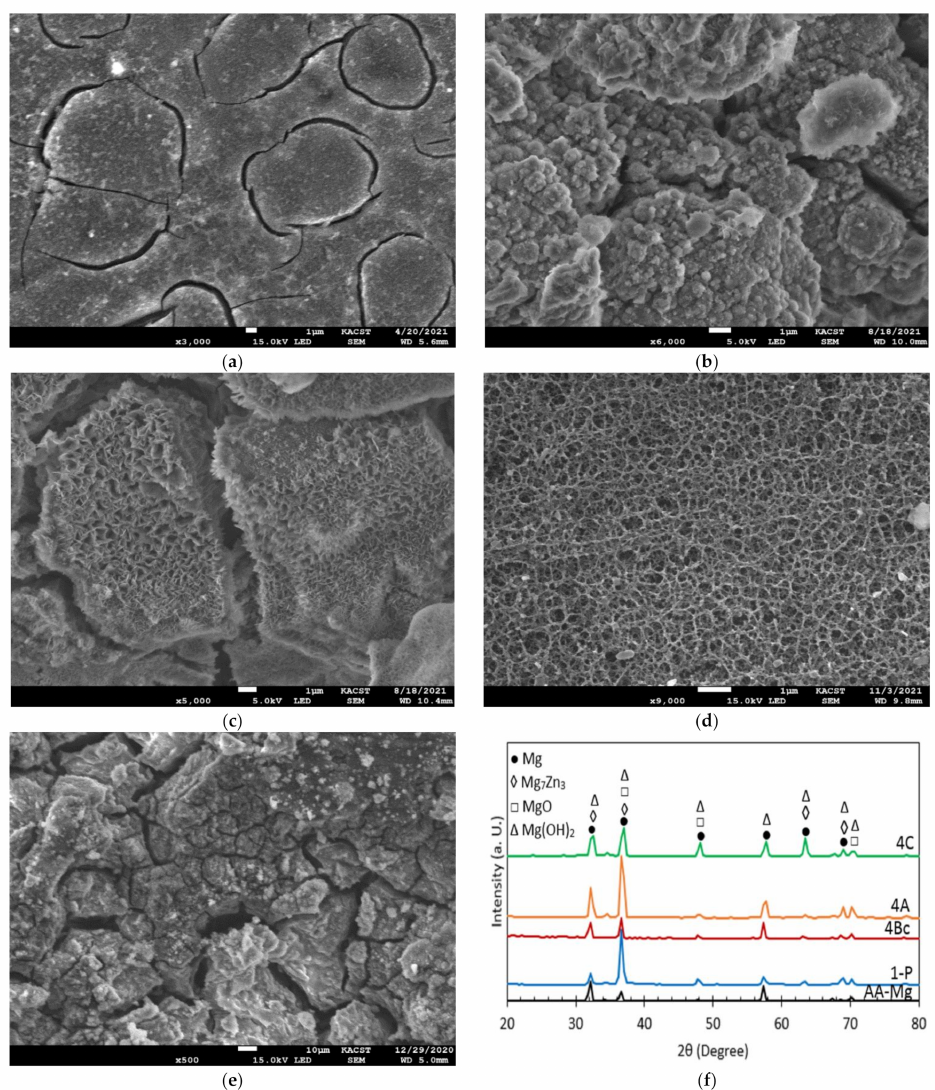
Figure 13. ( a – e ) SEM micrographs of the ZK30 alloy after corrosion testing. AA ( a ), ECAP processed through routes 1-P ( a ), 4-Bc ( c ), 4-A ( d ), 4-C ( e ), and ( f ) X-ray diffraction patterns of ZK30 alloy after